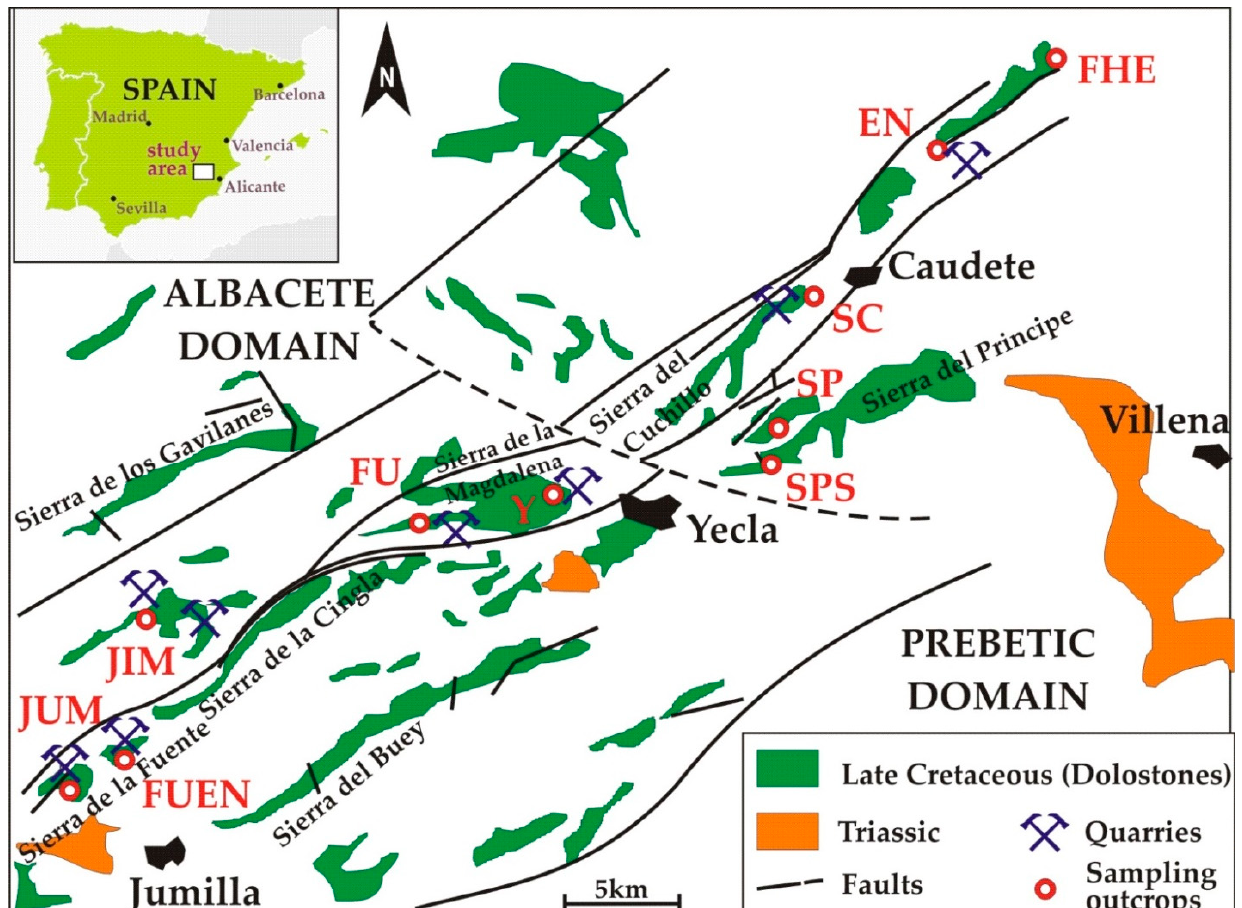
Figure 2. Distribution of the Late Cretaceous outcrops in the study area where extractions of the “Marrón Emperador” commercial marbles are concentrated. The Mesozoic tecto-sedimentary domains of the Betic Margin, the main tectonic accidents and the situation of the studied sampling outcrops and quarries are indicated. Northeast Sector: FHI-Fuente la Higuera (Valencia); EN-La Encina (Alicante); Central Sector: SC-Sierra del Cuchillo (Albacete); SP- and SPS-Sierra del Príncipe (Murcia); Y-Sierra de la Magdalena Este (Yecla, Murcia); FU-Sierra de la Magdalena Oeste (Murcia); Southwest Sector: JIM-Sierra de la Cingla (Murcia); FUEN-Sierra de la Fuente (Murcia); JUM-Jumilla (Murcia).